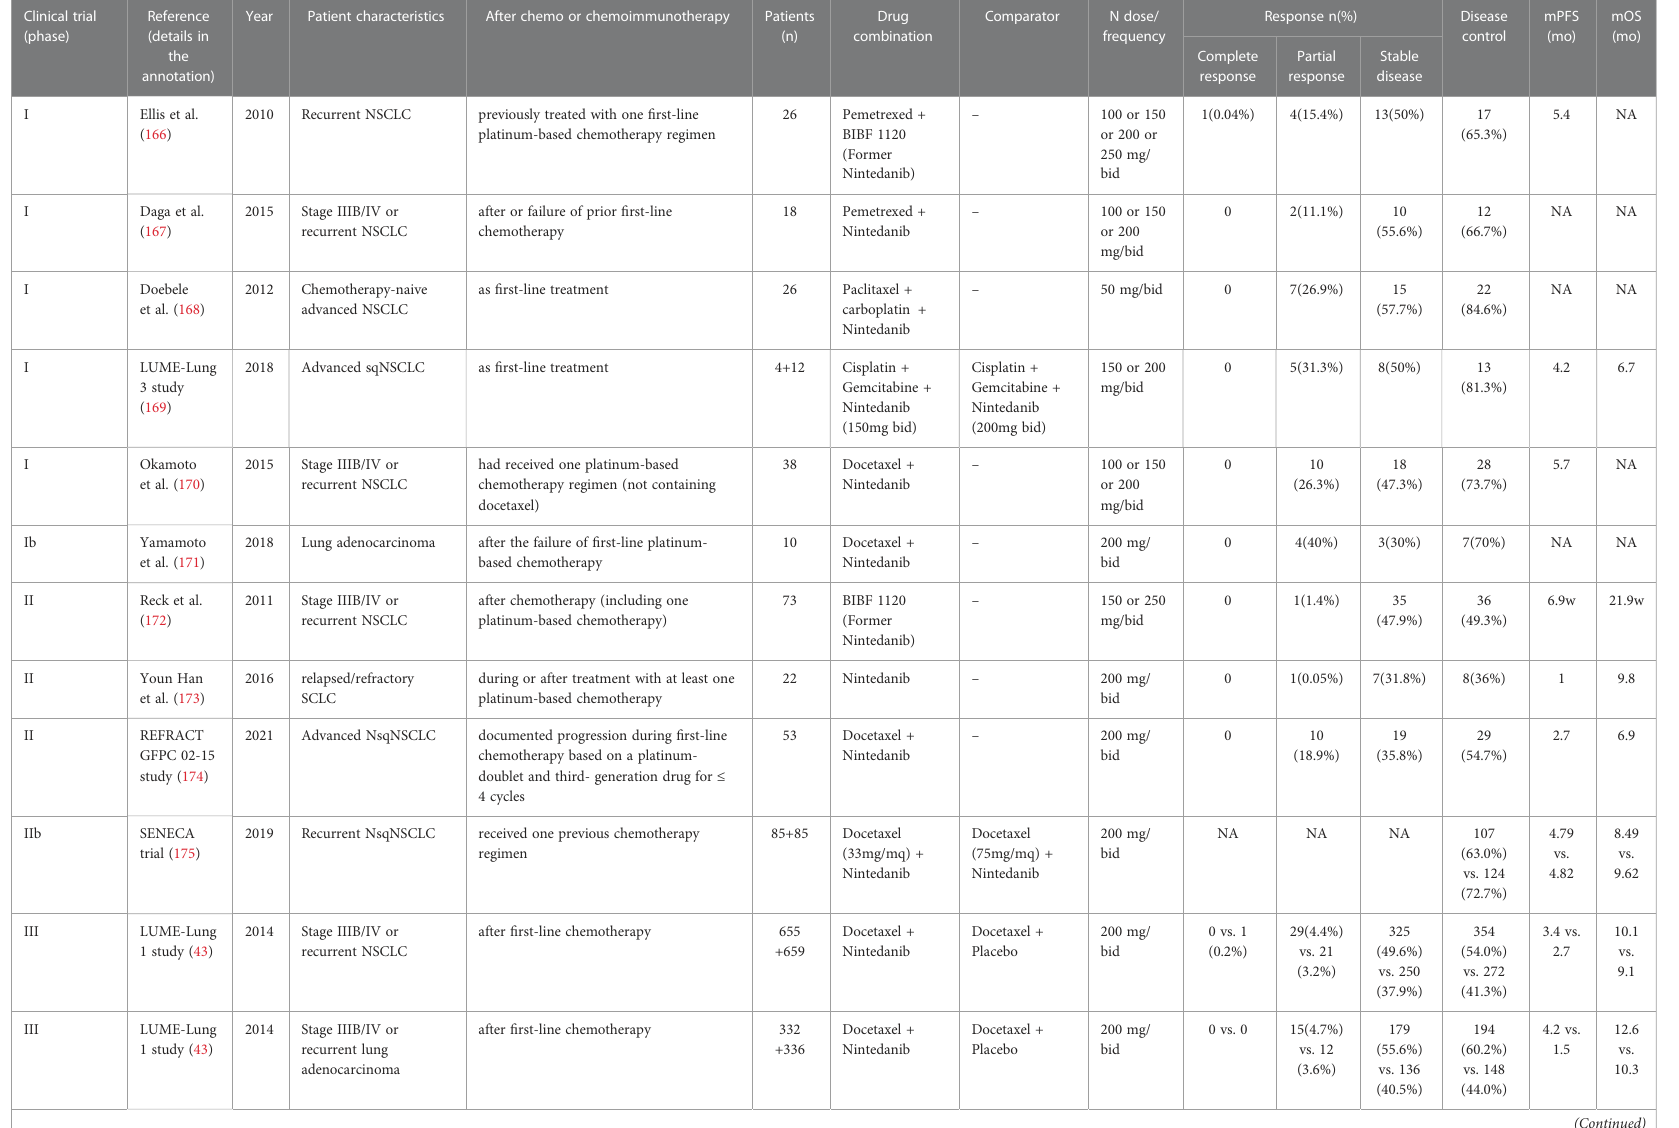
TABLE 2 From phase I to phase III clinical trials on nintedanib for lung cancers. Clinical trial